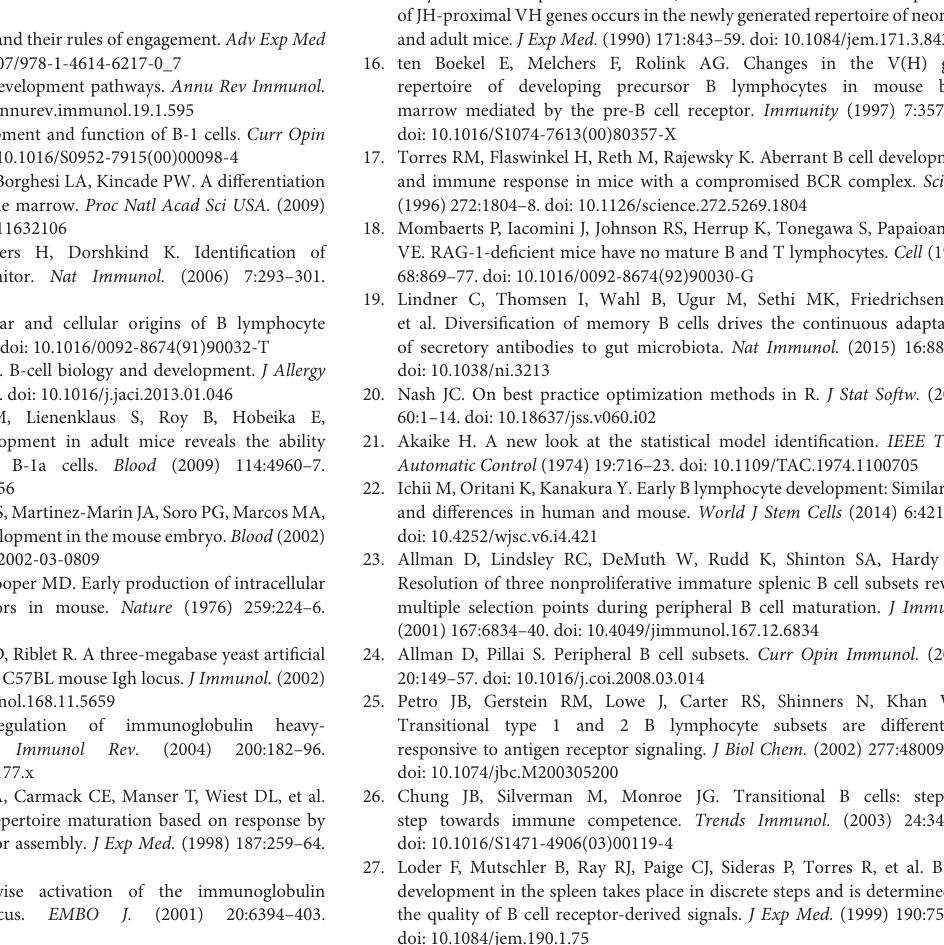
Supplementary Figure S2 | Results of least squares fitting. In each case, a constant, a linear and a bell-shaped model were fitted. The lines shown